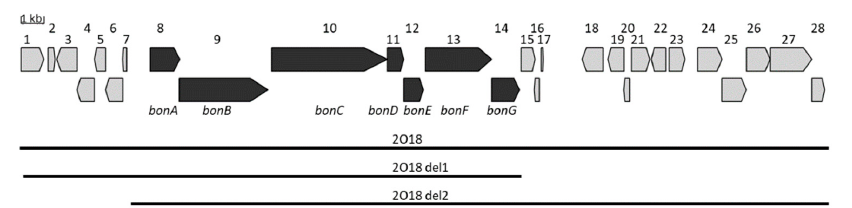
Figure 4. Fragment of the Streptomyces albus ssp. chlorinus NRRL B-24108 chromosome cloned in BAC 2O18. The genes putatively involved in bonsecamin biosynthesis are highlighted in dark grey. The black bars indicate the chromosomal fragments cloned in BACs 2O18, 2O18_del1 and 2O18_del2